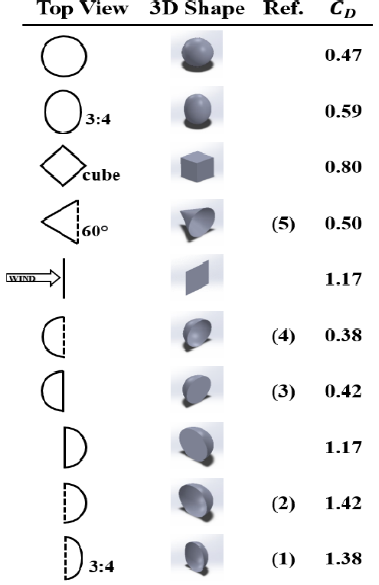
Figure 1. Referenced drag coefficients.